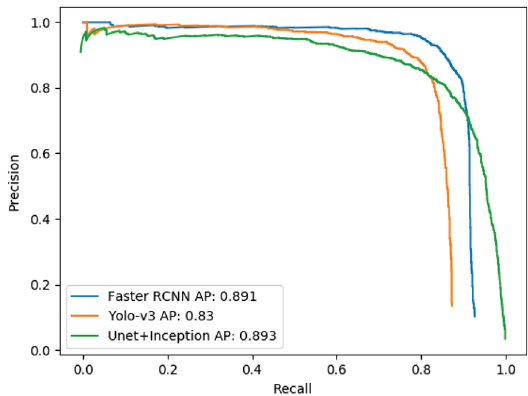
Fig. 8 Performance comparison for Faster RCNN, Yolo-v3, and our